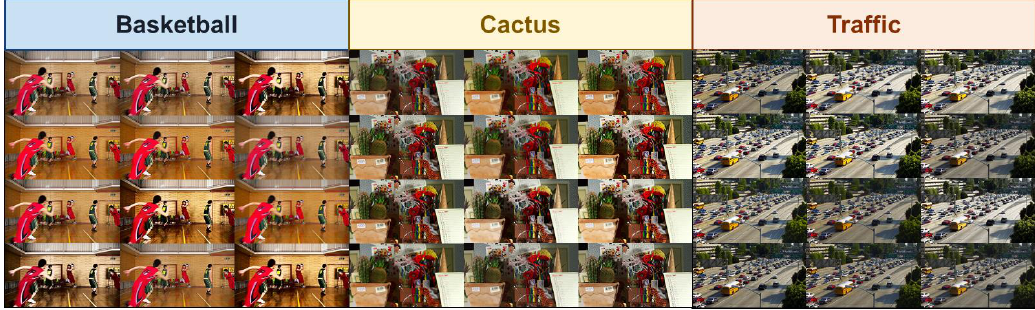
Figure 7. Examples of test images with various levels of colorfulness, contrast, and sharpness adjustments.